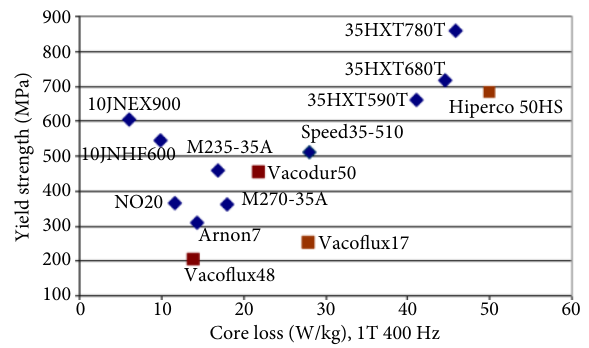
Fig. 3 Comparison of core-losses and yield strength for different high-per- formance electrical steels (reprinted with permission from Ref. [42], © 2013 IEEE).